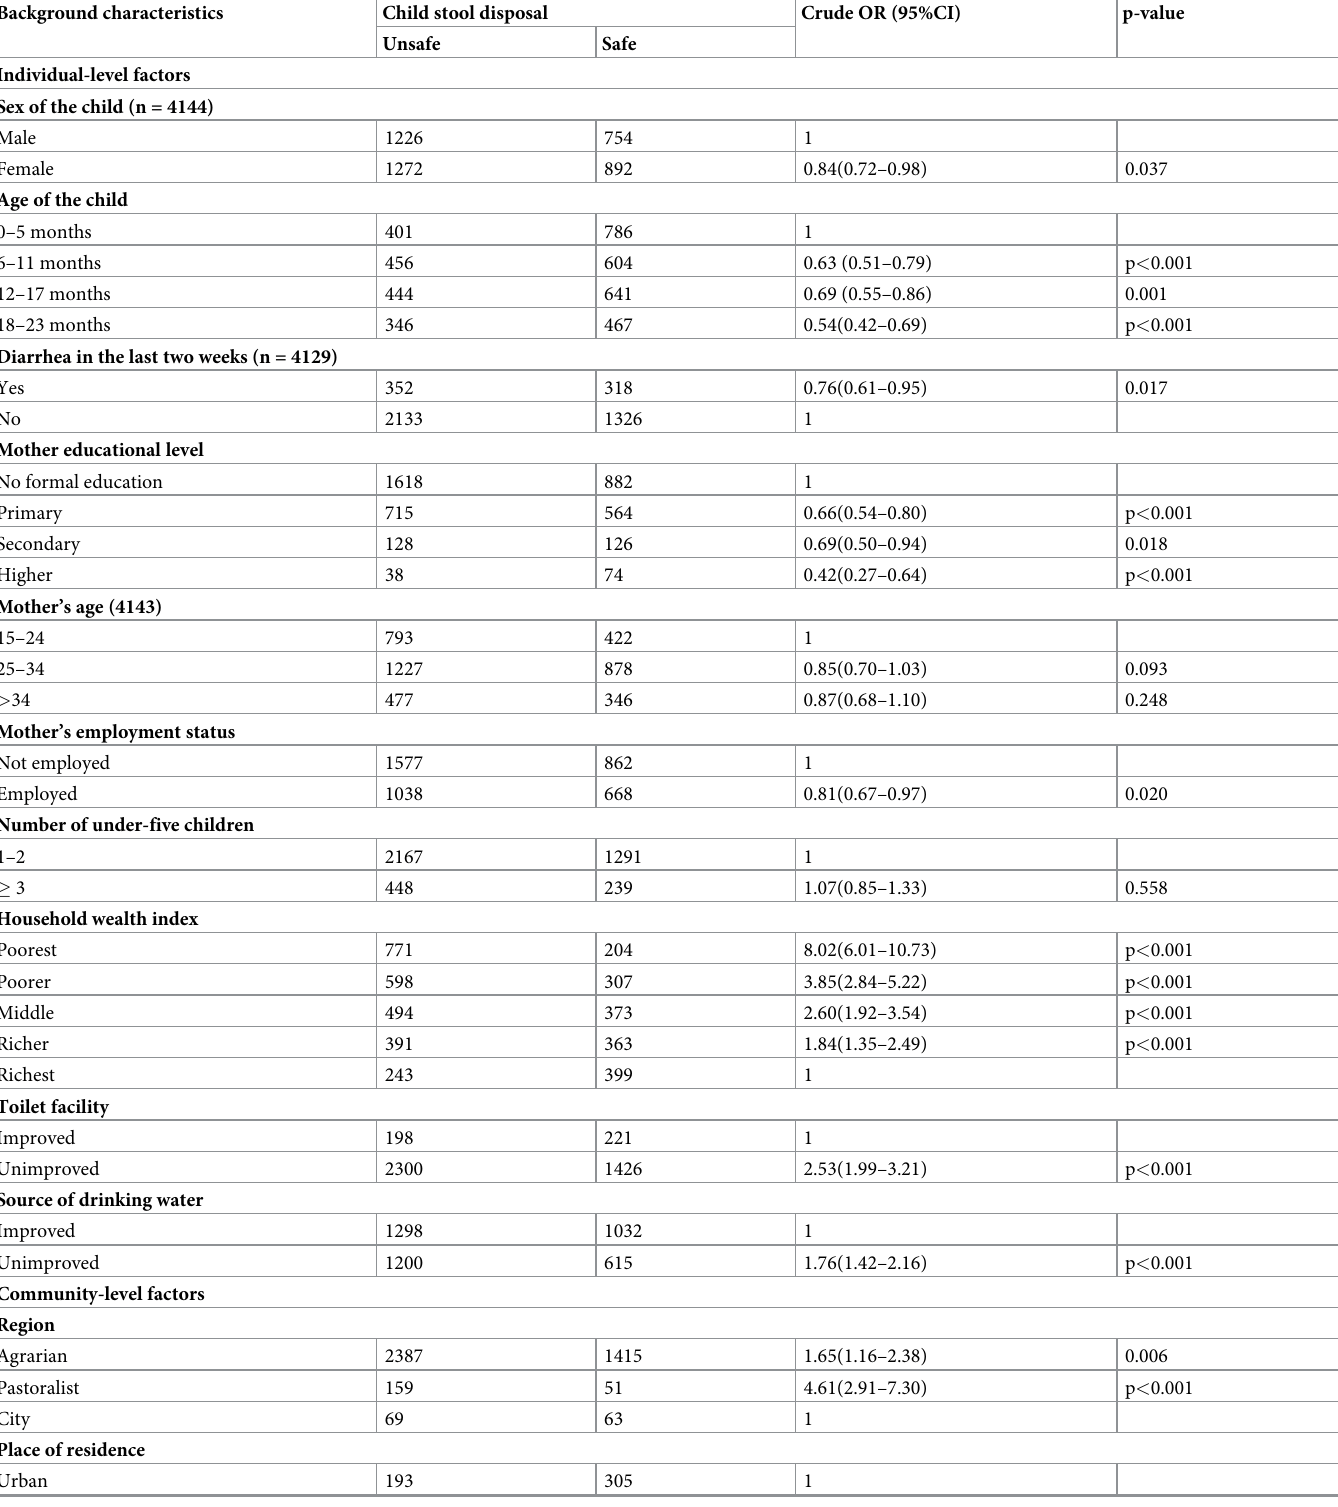
Table 3. Binary multilevel logistic regression analysis to determine associated factors of unsafe child stool disposal in Ethiopia, EDHS